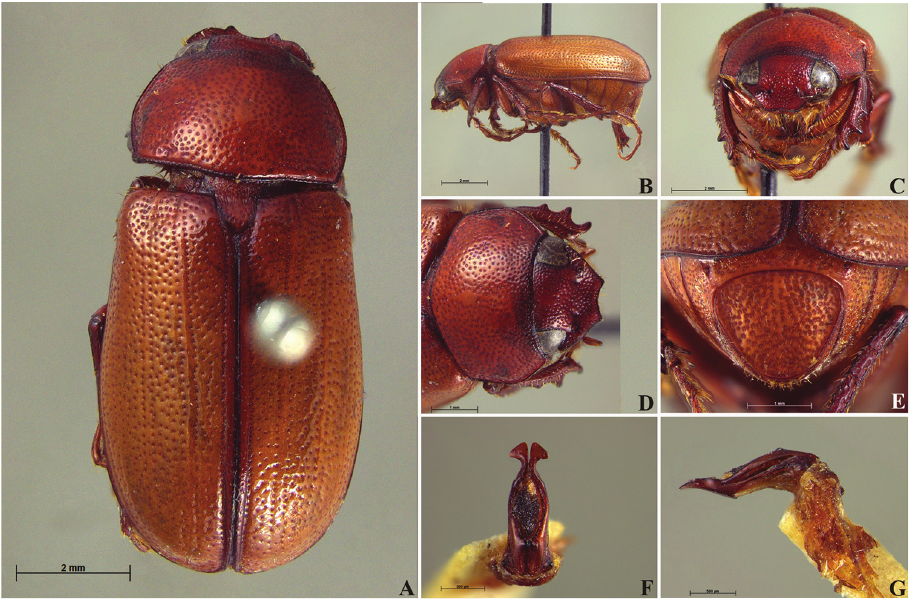
Figure 58. Liogenys bidenticeps Moser. A Dorsal view B Lateral view C Frontal view D Clypeus and pronotum E Pygidium F Parameres, dorsal view G Parameres, lateral view. 2012”. Female syntype of L. bicuspis : [white printed] “Brasilia/[handwritten]